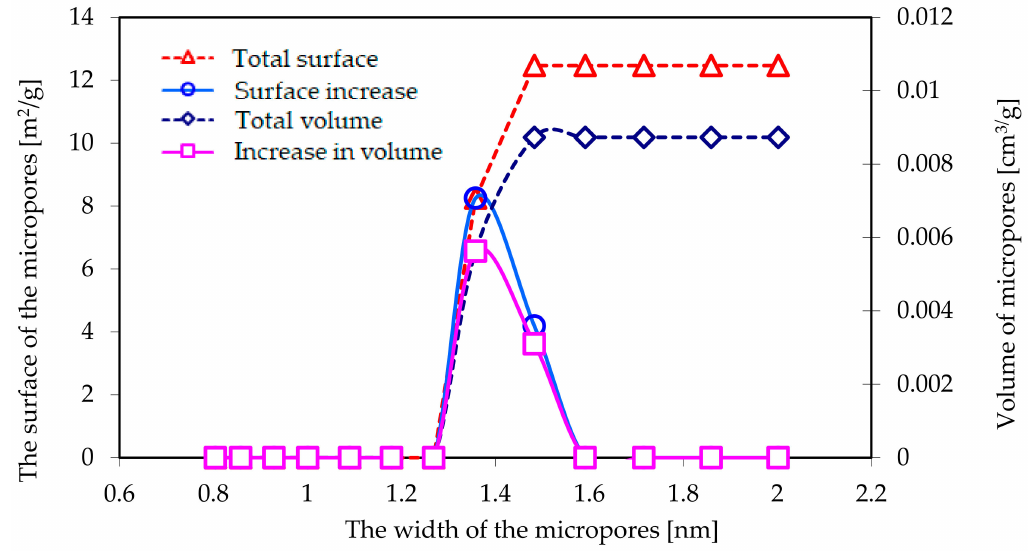
Figure 5. The relationship between the surface/volume of the micropores and their width as calculated with DFT method based on the nitrogen adsorption